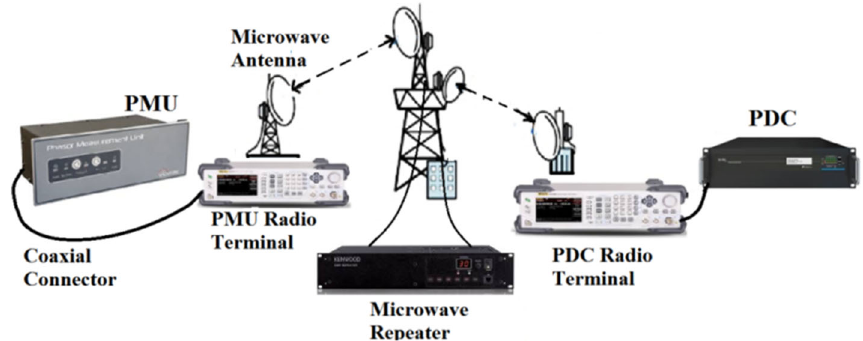
Fig. 2 Basic components of a